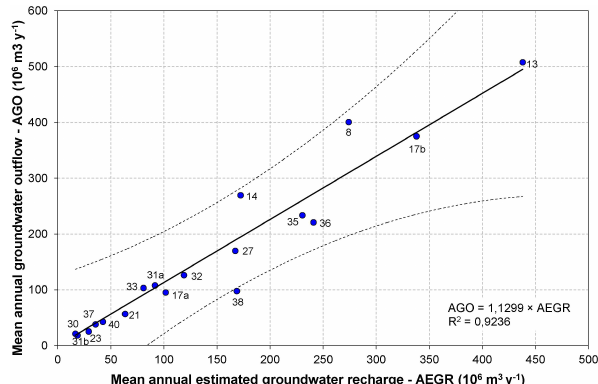
Fig. 9. Correlation between mean annual groundwater outflow (AGO) assessed by non-systematic spring discharges measurements and mean annual estimated groundwater recharge (AEGR). The numbers correspond to the aquifers’ ID. The 95% confidence bands are also